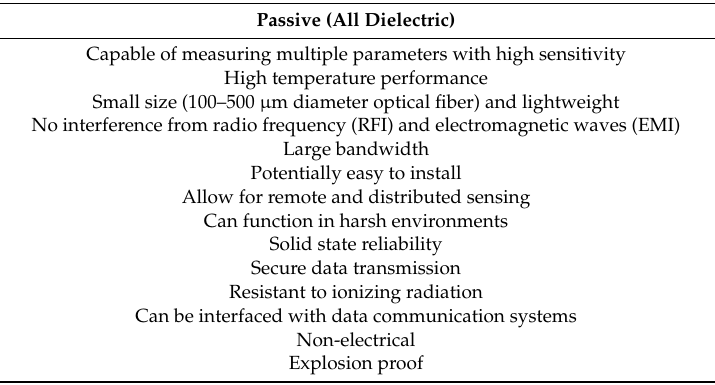
Table 1. Advantages of fiber optic sensors .